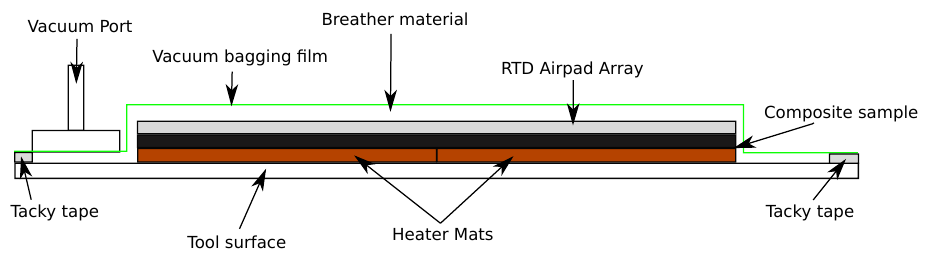
Figure 5. Resistance temperature detector (RTD), sample and heater mat experimental set up within vacuum bagging.